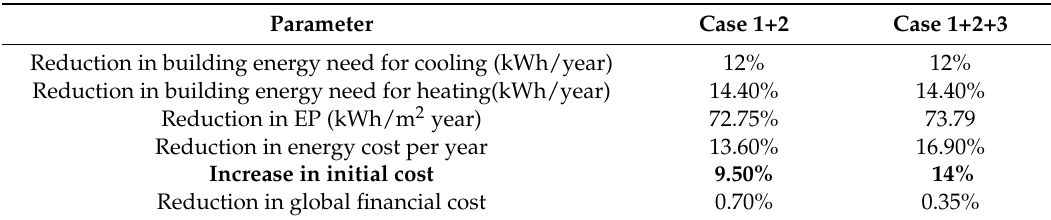
Table 6. The improvements in energy consumption per year for cooling and heating, reduction in energy performance, and other